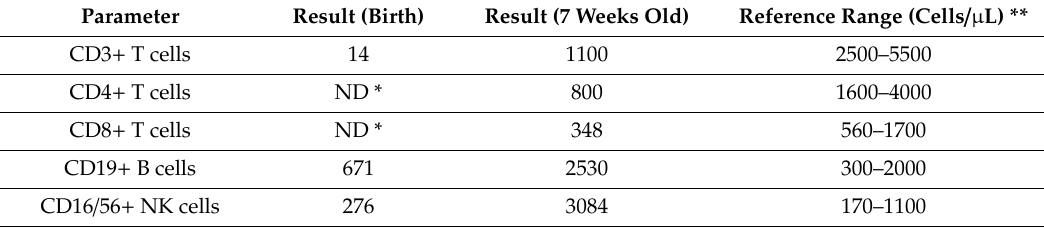
Table 5. Case 3, Lymphocyte subset analysis.